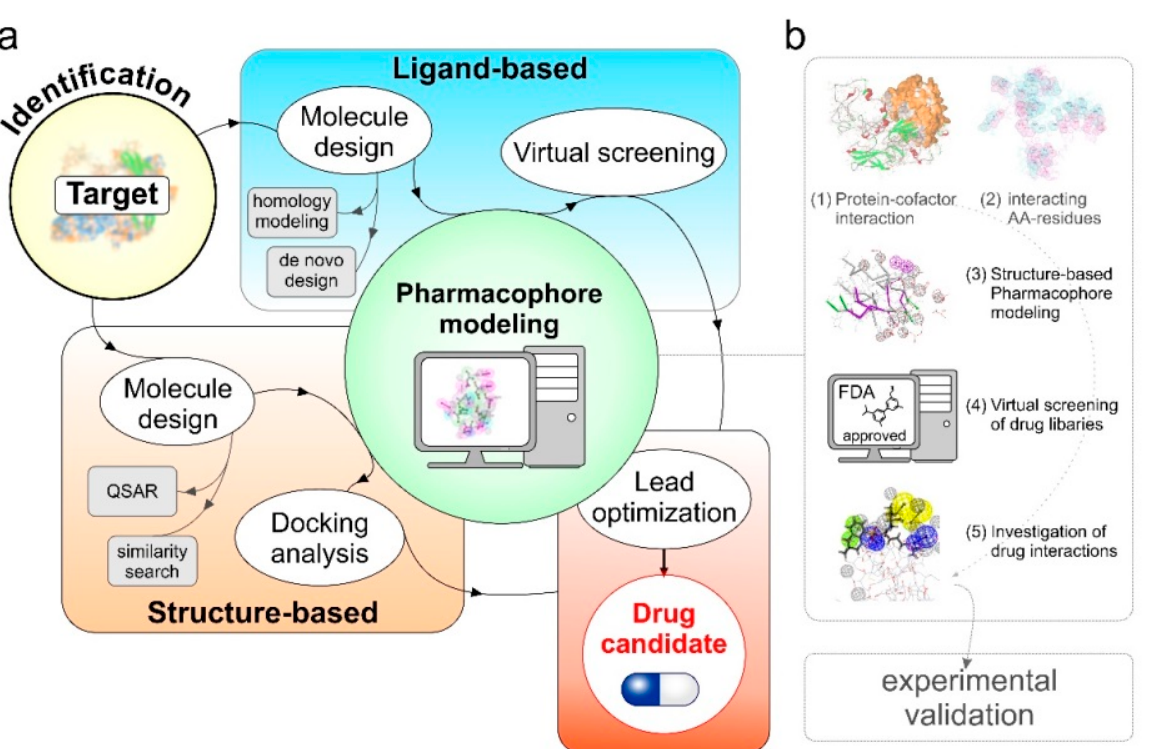
Figure 3. Overview of drug candidate screening from target identification including the